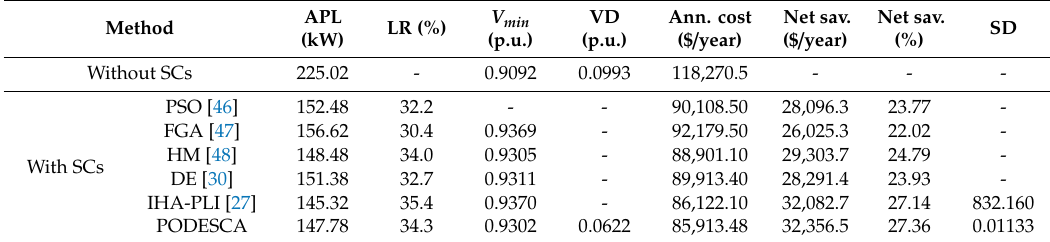
Table 4. Comparison of results between PODESCA and other methods for the 69-bus system.